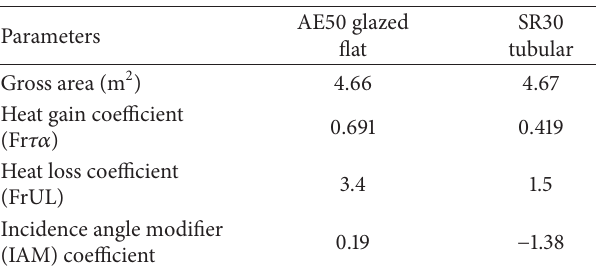
Table 2: Collector